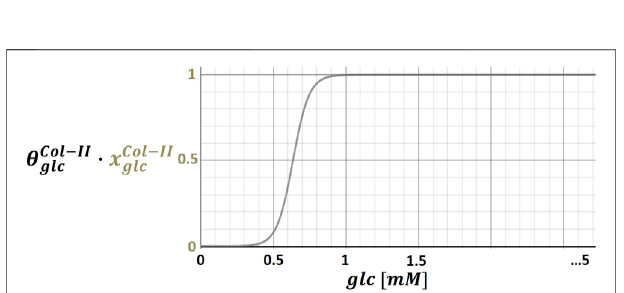
FIGURE 2 | Illustration of stimulus-cell activity relationships by means of the glucose (glc) – collagen type II (Col-II) relationship; continuous functions assign physiologically relevant glc concentrations (i.e. 0 - 5 mM) to a normalized Col-II mRNA expression, which was multiplied by an individual weighting factor ( θ CA S